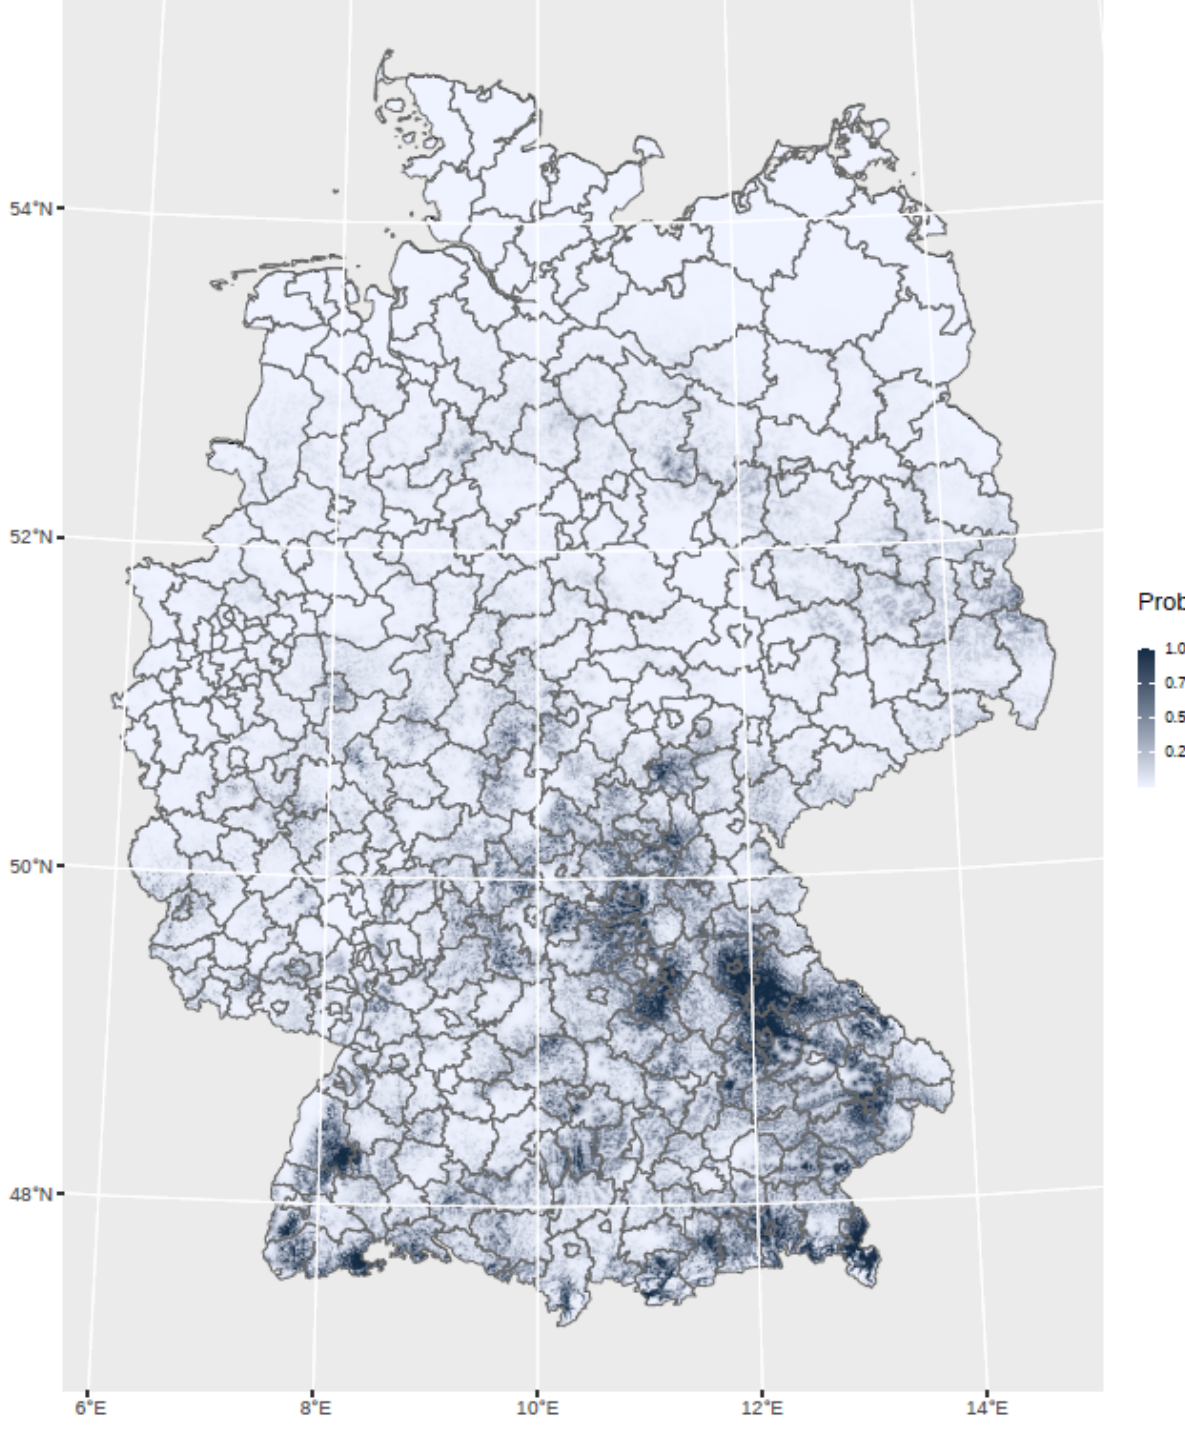
Figure 5. MaxEnt predicted probabilities for Germany based on the locations of the TBEV microfoci and environmental data. The probability is displayed in different grey shades.